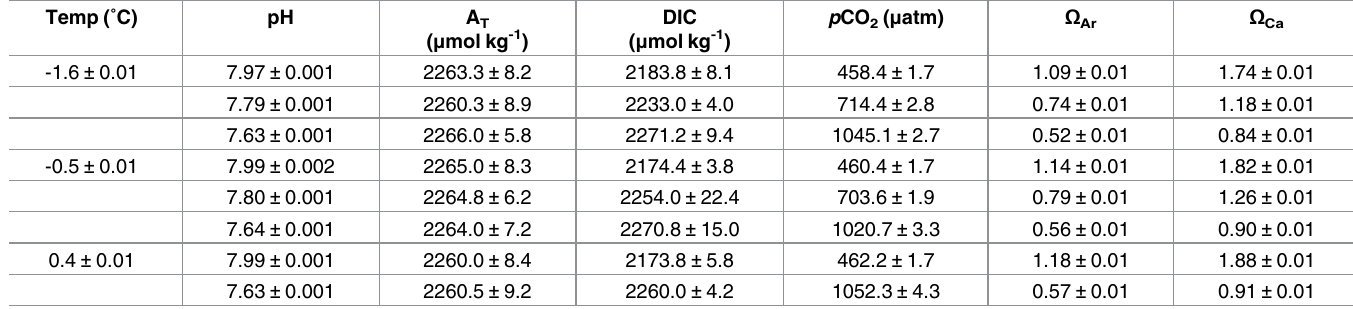
Table 1. Seawater conditions for all experimental